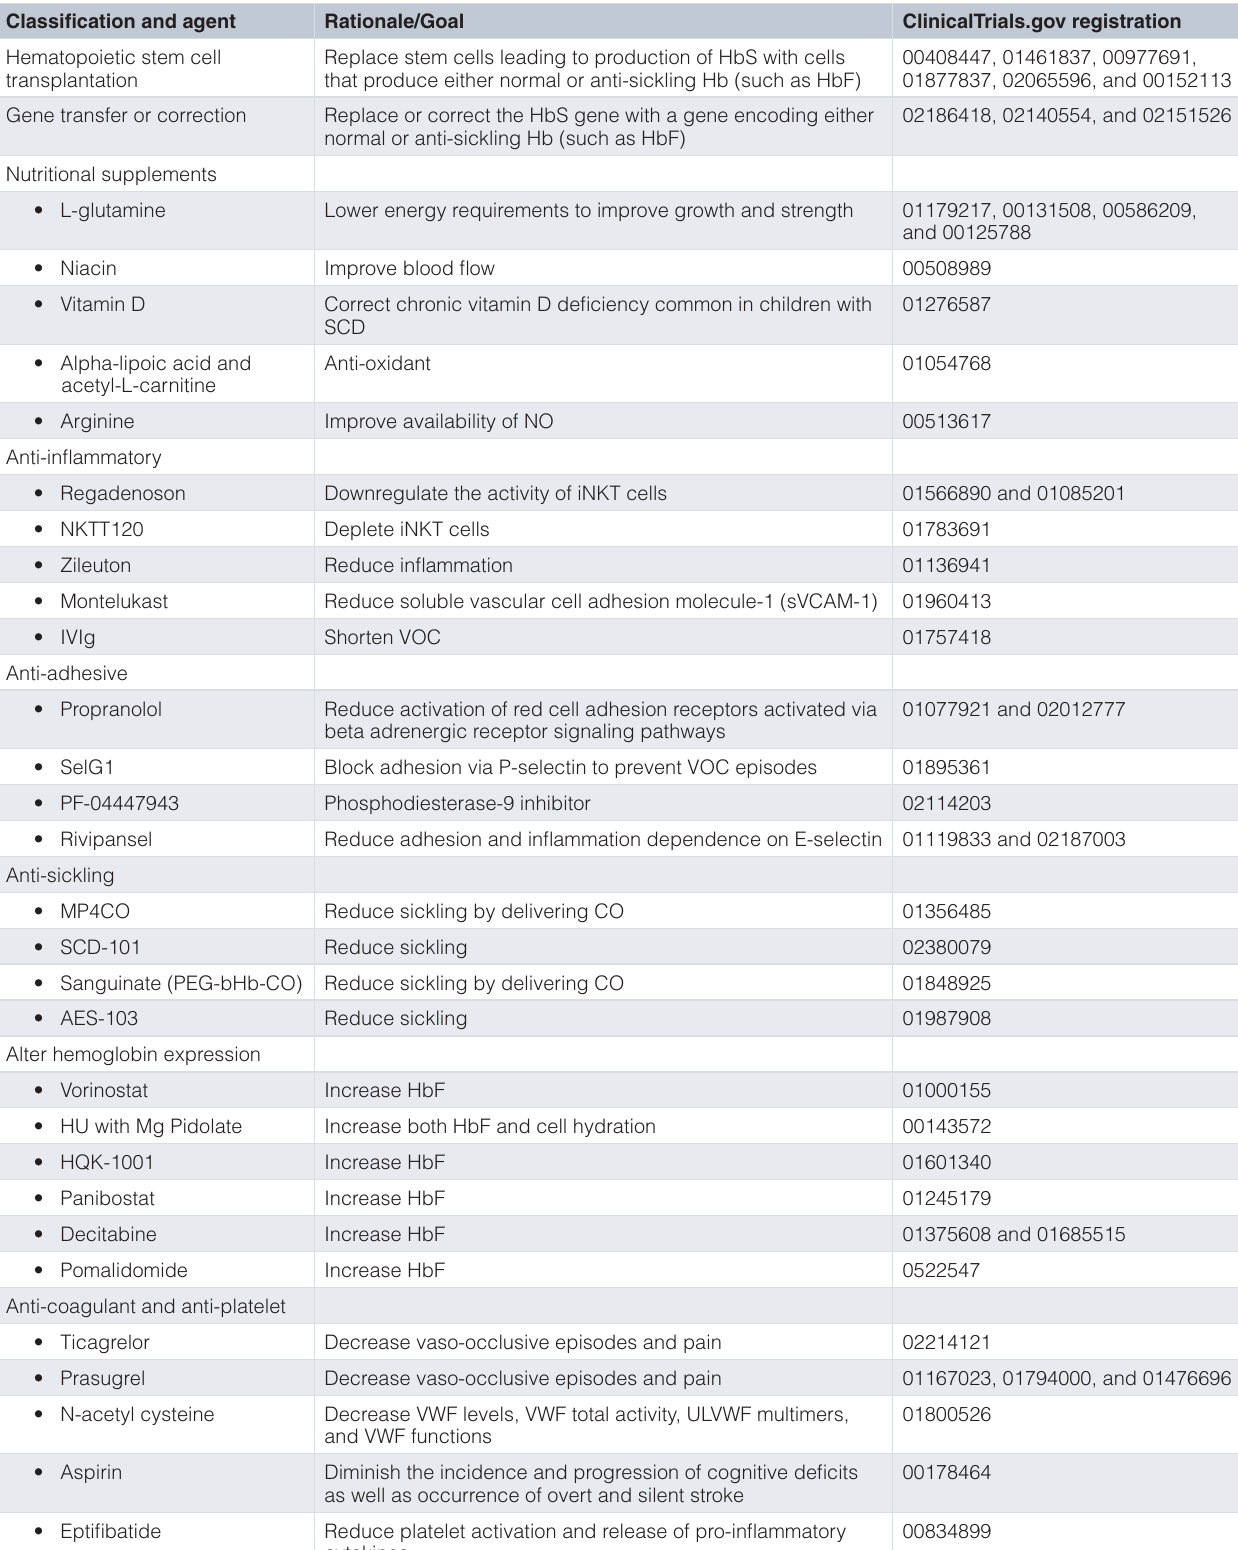
Table 2. New therapeutic approaches under investigation or recently investigated for sickle cell disease. Classification and